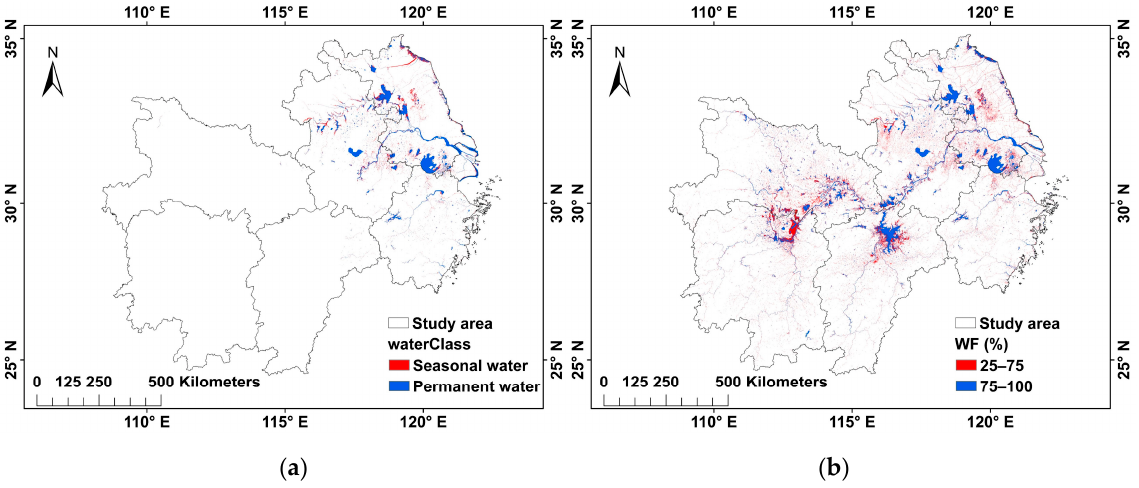
Figure 11. ( a ) JRC yearly water classification historical data; ( b ) WF year data of this paper for the MLYP in